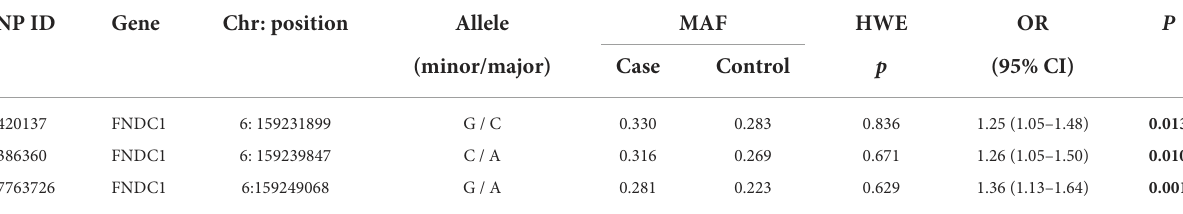
TABLE 2 Basic information of SNPs in FNDC1 gene.